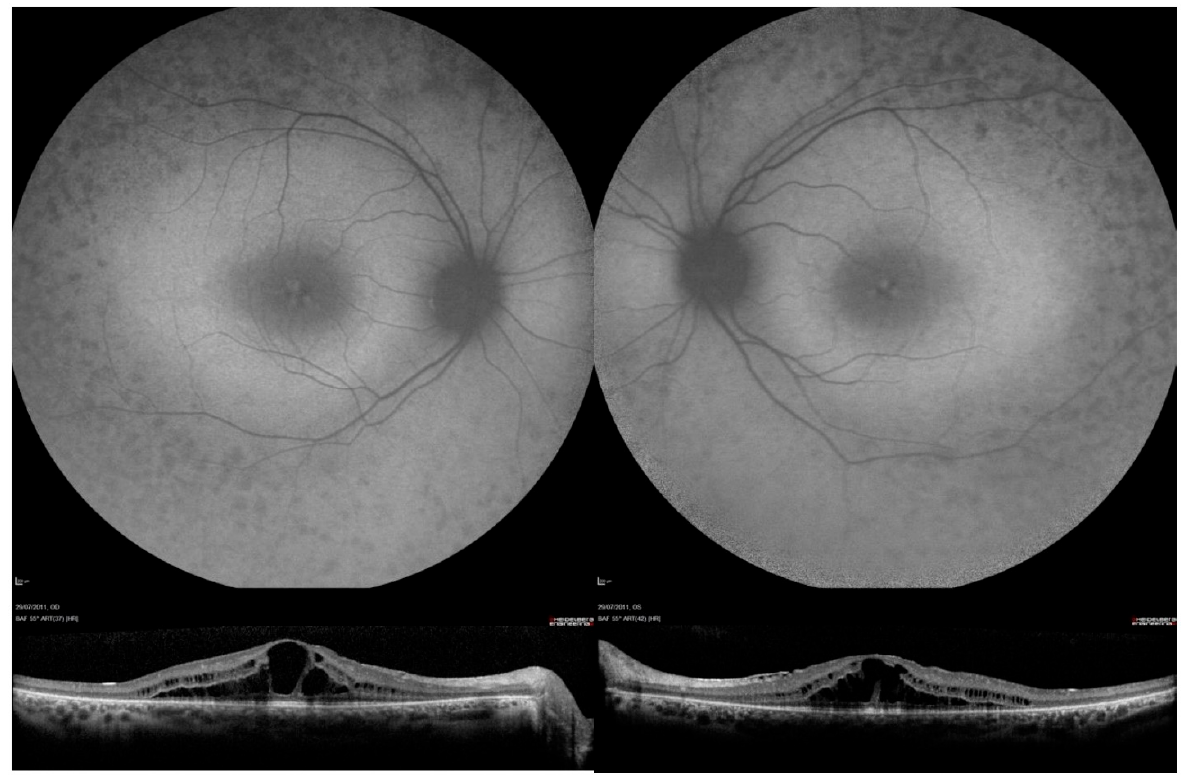
Figure 2. Fundus autofluorescence (FAF) and optical coherence tomography OCT imaging in patient 41, who was compound heterozygous for USH2A variants c.2299del and c.8740C > T, p.(Arg2914*). FAF images showed decreased AF signal in the mid-peripheral retinal, raised macular AF and speckled area of raised foveal AF. OCT images show bilateral central cystoid macular oedema.